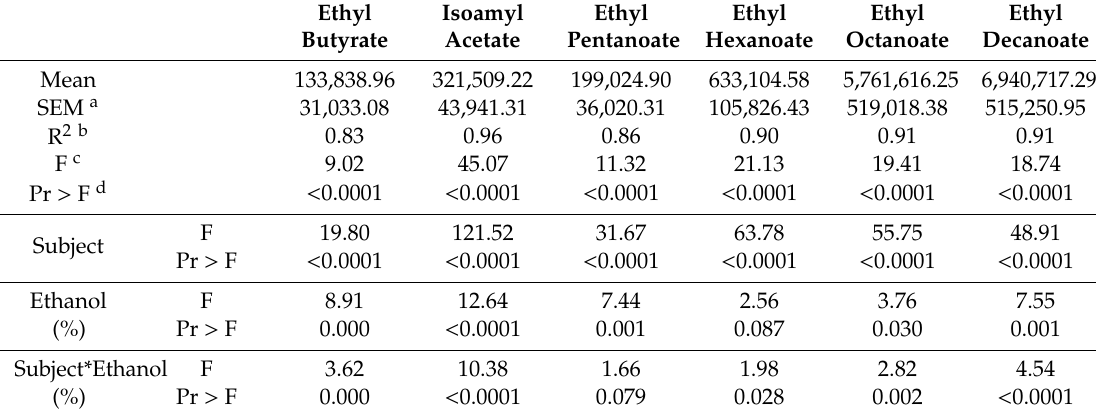
Ethyl Isoamyl Ethyl Ethyl Ethyl Ethyl Butyrate Acetate Pentanoate Hexanoate Octanoate Decanoate